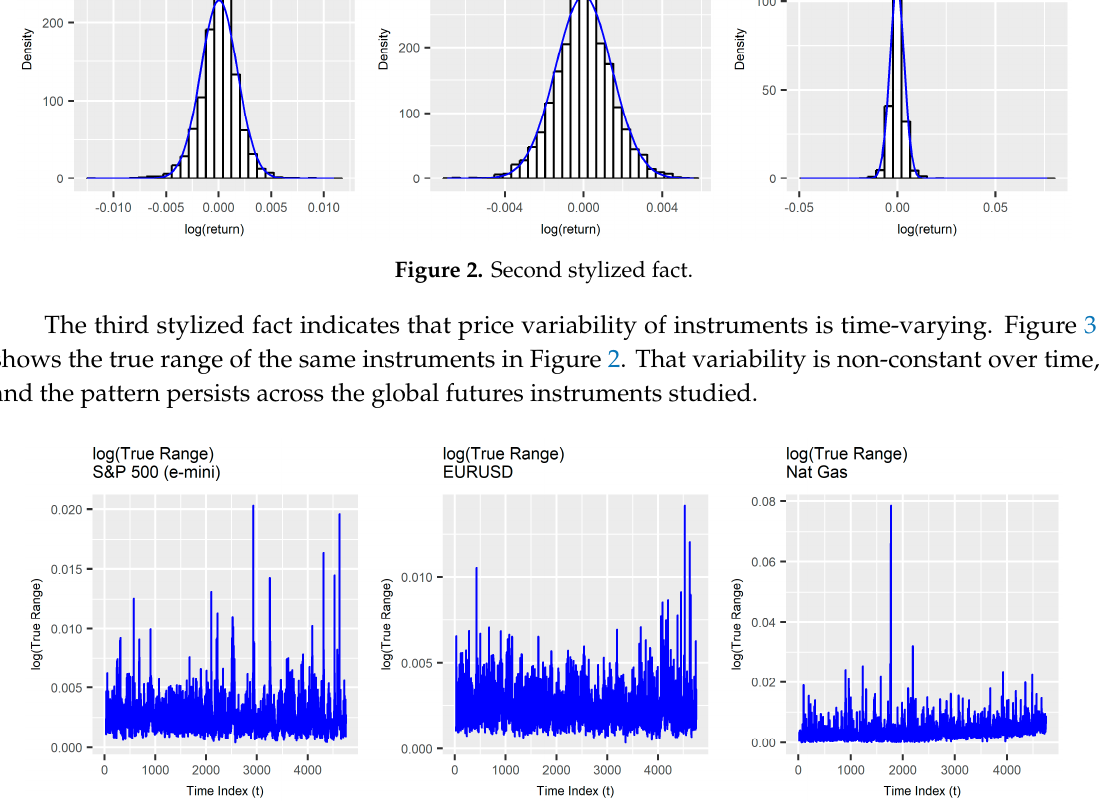
Figure 3. Third stylized fact.